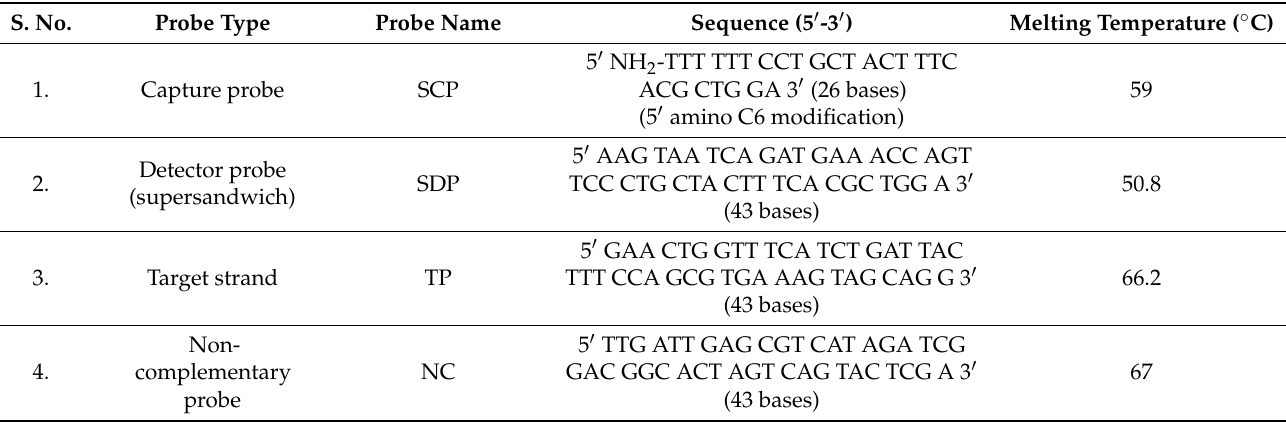
Table 1. Oligonucleotide probes used in the